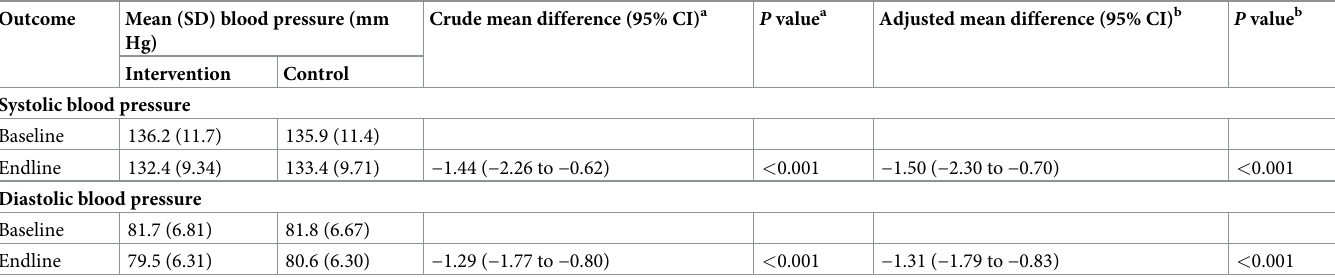
Intervention, n = 13,385; control, n = 14,745. a The intervention minus control crude mean endline differences were obtained via a linear mixed-effects model with a single fixed effect of treatment arm and a random intercept for cluster. The 95% CI and P values were calculated based on the t statistic. In both crude analyses there were no missing patients. b The intervention minus control adjusted mean endline differences were obtained via a linear mixed-effects model with fixed effects for treatment arm, patient age, sex, body mass index, occupation (farmer or non-farmer), educational level (primary school or below, or high school or above), marital status (married or non-married), income (less than 10,000 RMB or 10,000 RMB or above), and diagnosis (hypertension without type 2 diabetes, type 2 diabetes without hypertension, hypertension with type 2 diabetes), and a random intercept for cluster. The 95% CI and P values were calculated based on the t statistic. In the adjusted analysis of the systolic blood pressure outcome, 2,624 (19.6%) and 3,339 (22.6%) patients in the intervention and control arms, respectively, were excluded due to missing covariate or outcome data, and in the adjusted analysis of the diastolic blood pressure outcome 2,620 (19.6%) and 3,338 (22.6%) patients in the intervention and control arms, respectively, were excluded due to missing covariate or outcome